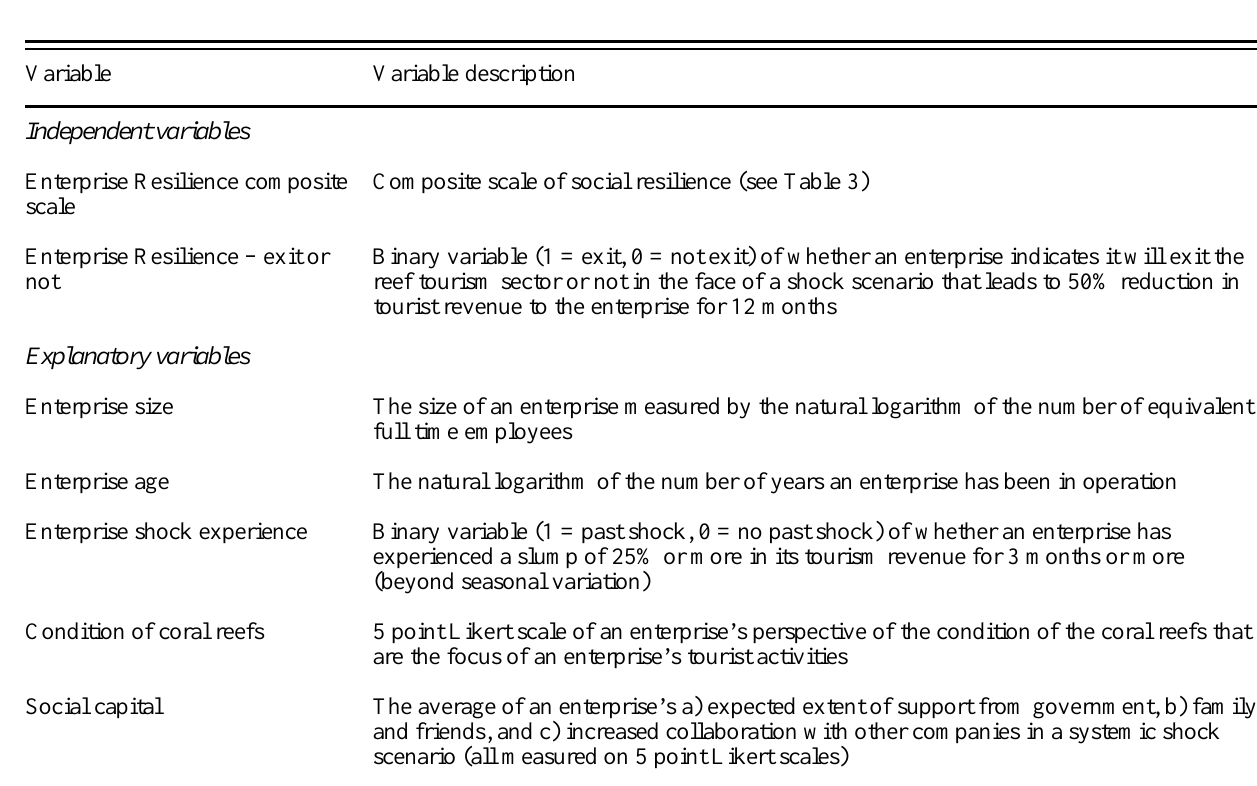
Table 1. List of independent and explanatory variables used in this study. The interviewees from enterprises were either owners or senior